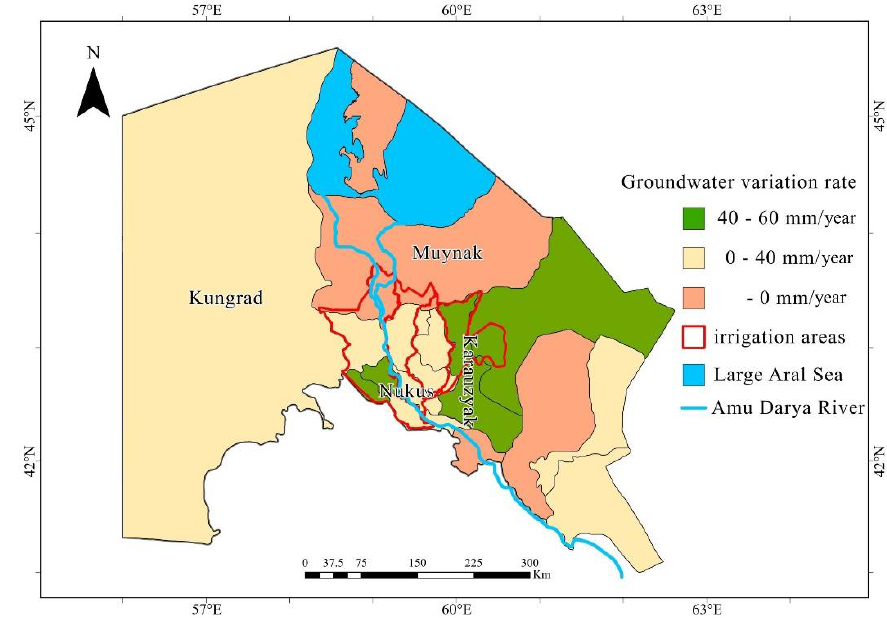
Figure 6. Spatial distribution of groundwater variation trend in 1999–2017 (The data series of regional groundwater average was calculated basing on all wells in the district).